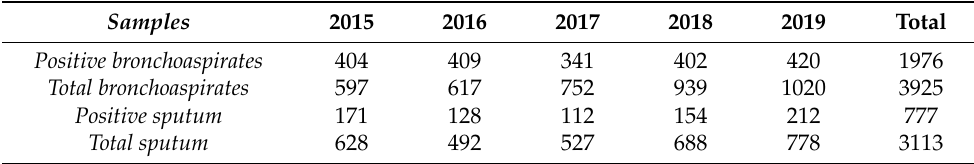
Table 1. Cases of LTRIs distributed by